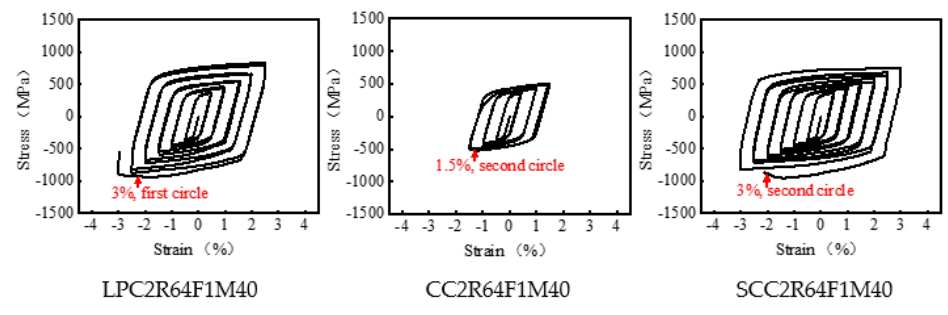
Figure 13. Hysteretic response curves of the proposed LPBRBs.